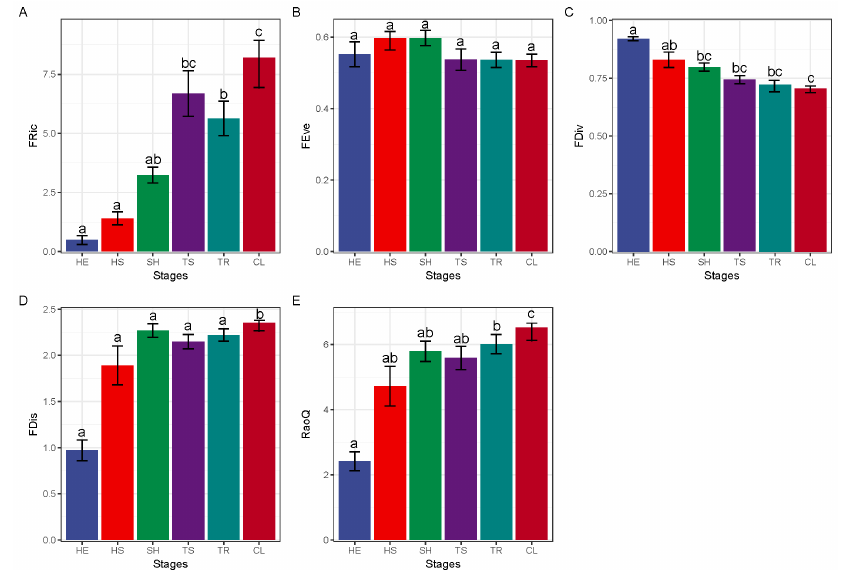
Figure 3. Functional diversity at different stages of recovery. FRic—functional richness index, FEve—functional evenness index, FDiv—functional divergence index, FDis—functional separation